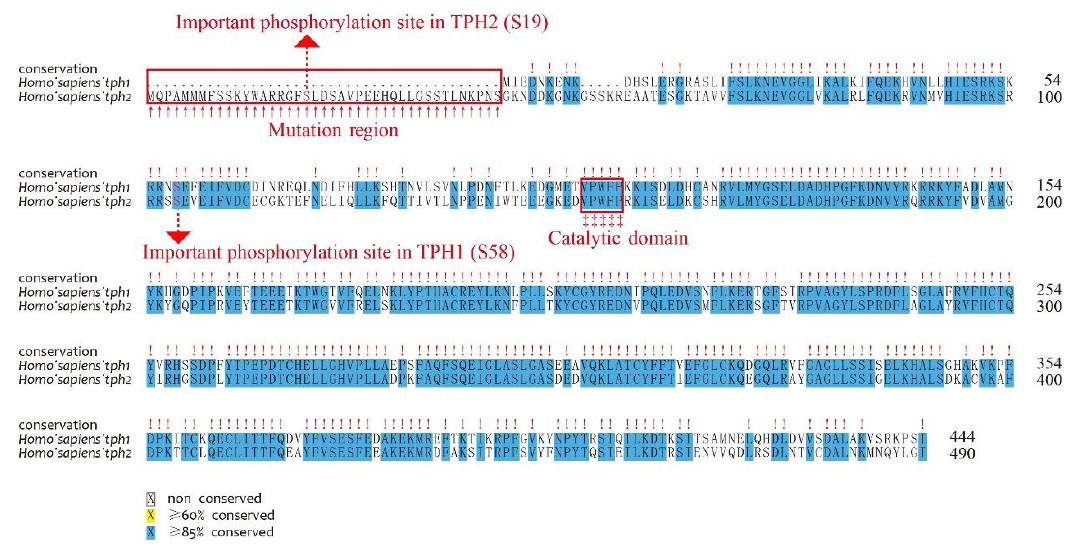
Figure 3. Alignment of human TPH1 and TPH2 protein sequences. Important residues include the mutation region (in the NH2-terminal red box), phosphorylation sites (dashed lines with red arrows), and catalytic domains (‡ with the red box).